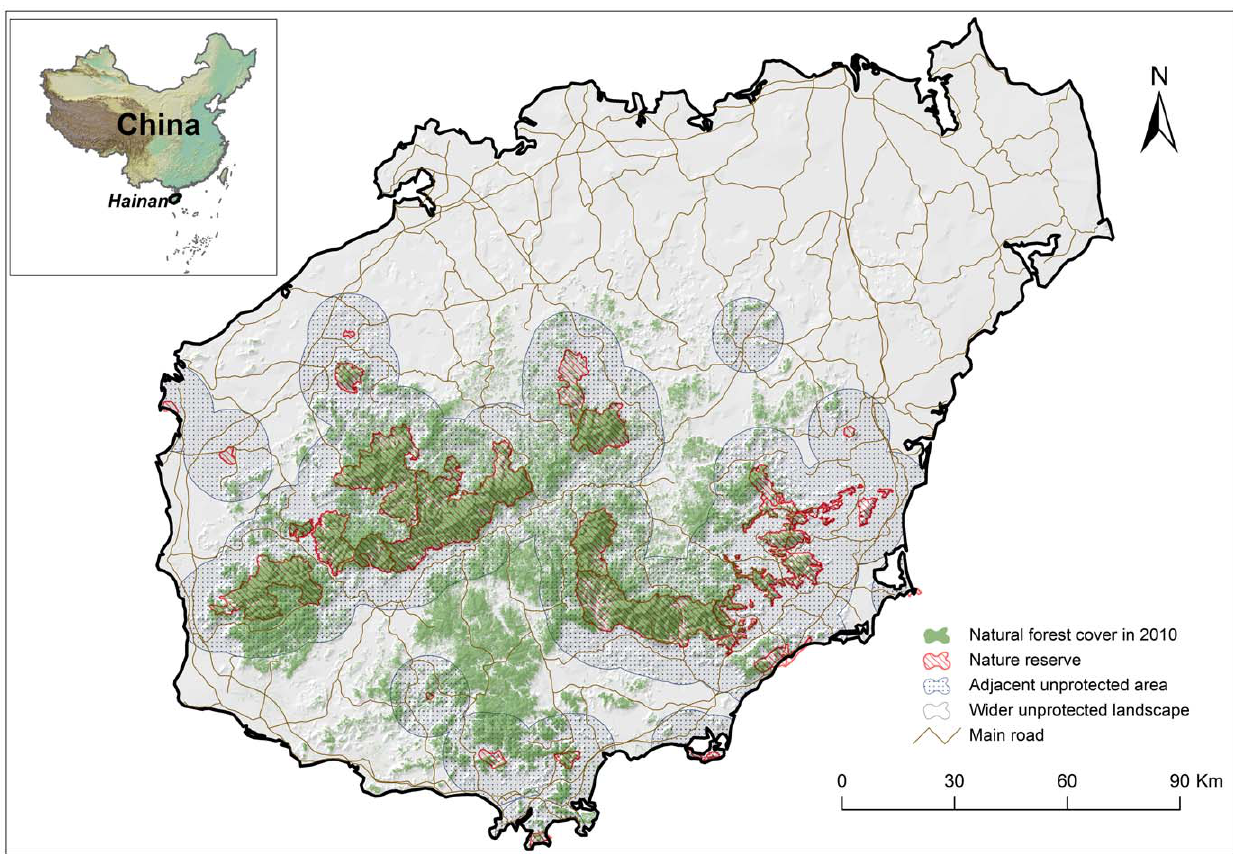
Figure 1. Nature reserve system of Hainan Island. The nature reserve system, adjacent unprotected areas (surrounding lands within 10 km of the nature reserve boundaries) and wider unprotected landscape (more than 10 km away from the nature reserve boundaries) overlaid with natural forest cover in 2010 and digital elevation model (DEM) of Hainan Island, China.